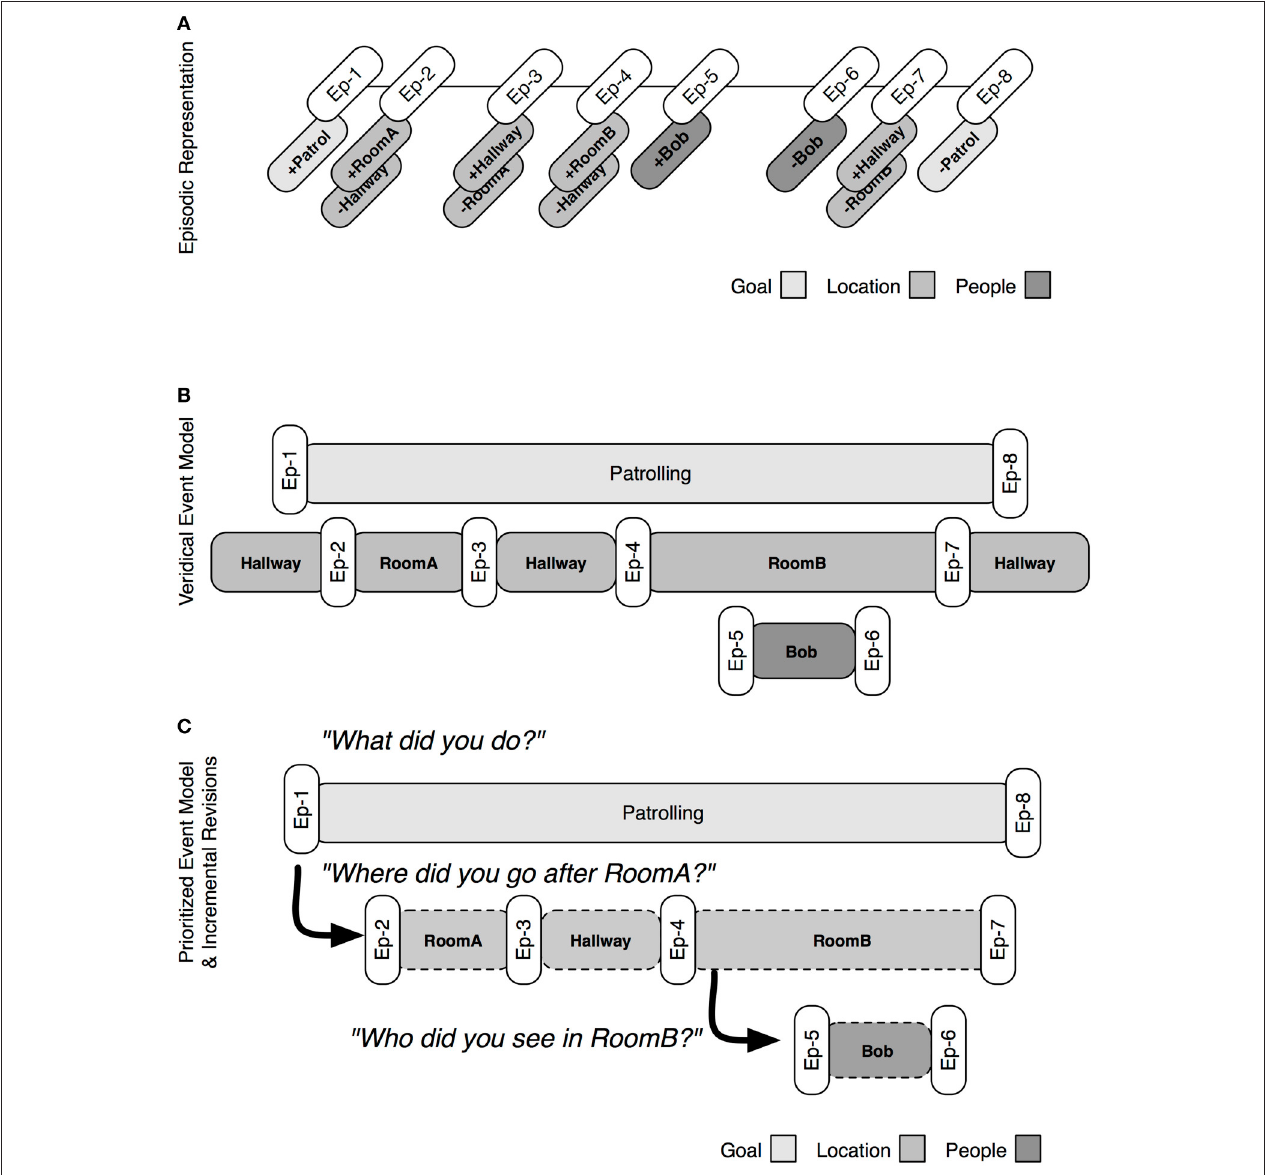
FIGURE 4 | The process by episodic markers are retrieved to build event models. (A) Shows the episodic representation (see also Figure 3B ). (B) Shows a veridical event model that can be constructed by an unprioritized mapping from episodic markers to model structures. (C) Shows a prioritized mapping, in which the construction of a goal event takes precedence to that of other sorts of events. Additional queries can be used to revise and flesh out the prioritized event